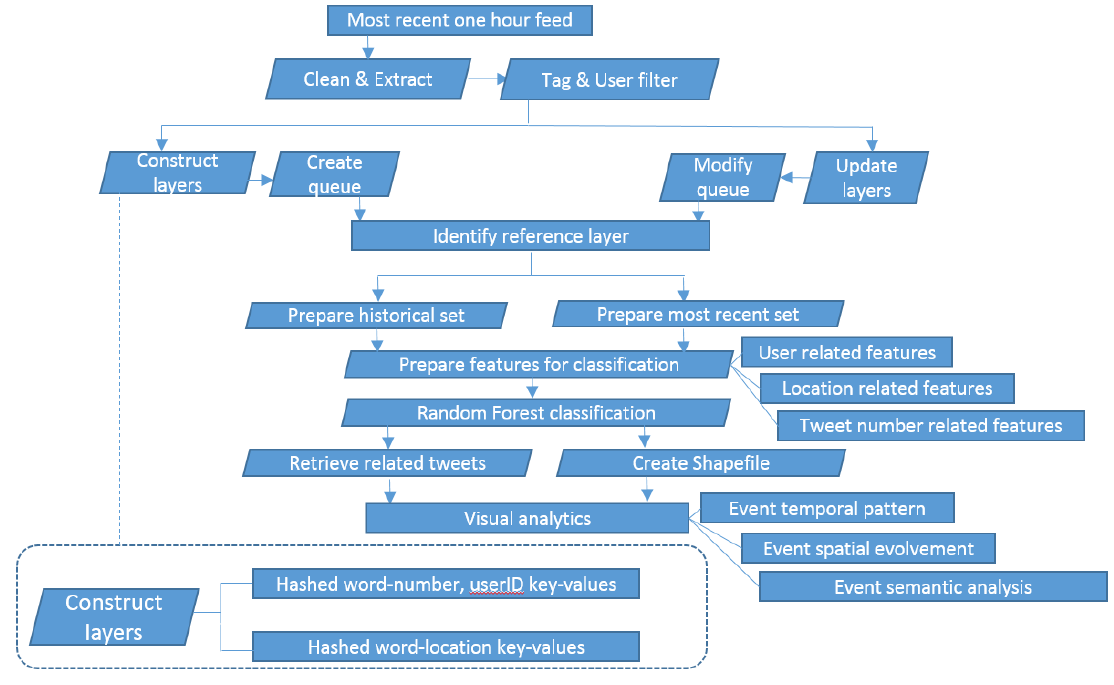
Figure 3. Data analysis flow of this study.